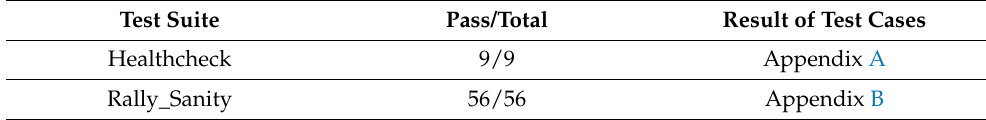
Table 5. Result of the functionality test.